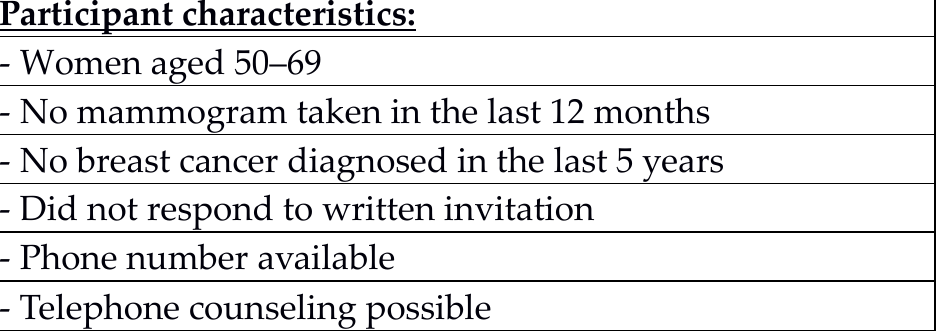
Figure 2. Participant characteristics.